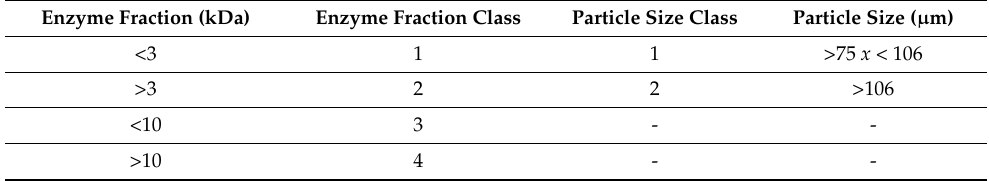
Table 5. Classification of the enzyme fraction and particle size for data analytics. Enzyme Fraction (kDa) Enzyme Fraction